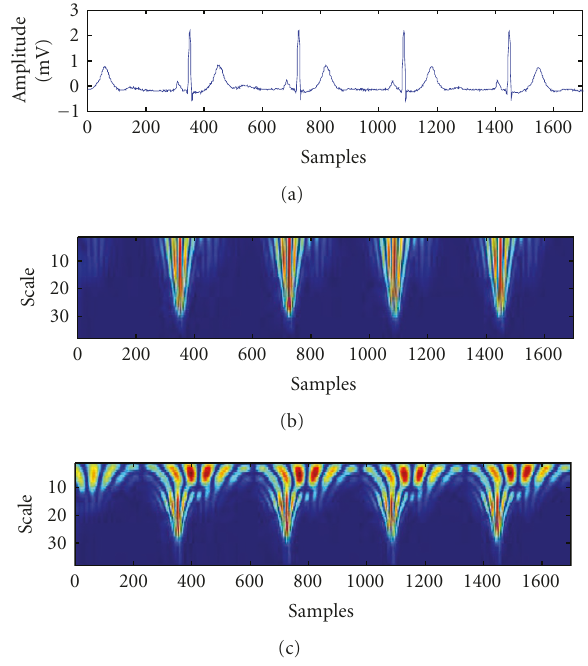
Figure 3: (a) MIT-BIH ECG record number 106, (b) time- frequency representation with WT, (c) the same representation with